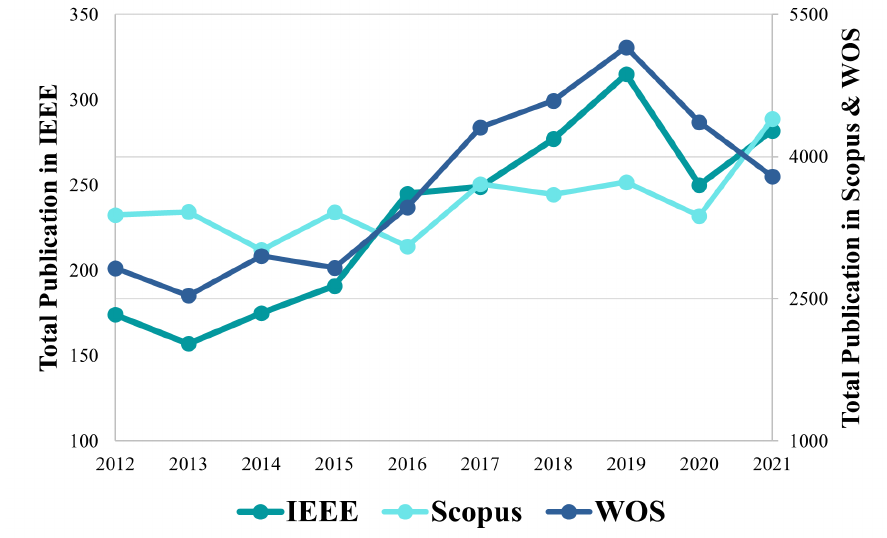
Figure 2. Research produced in gas turbine area from IEEE, Scopus, and WOS Database.